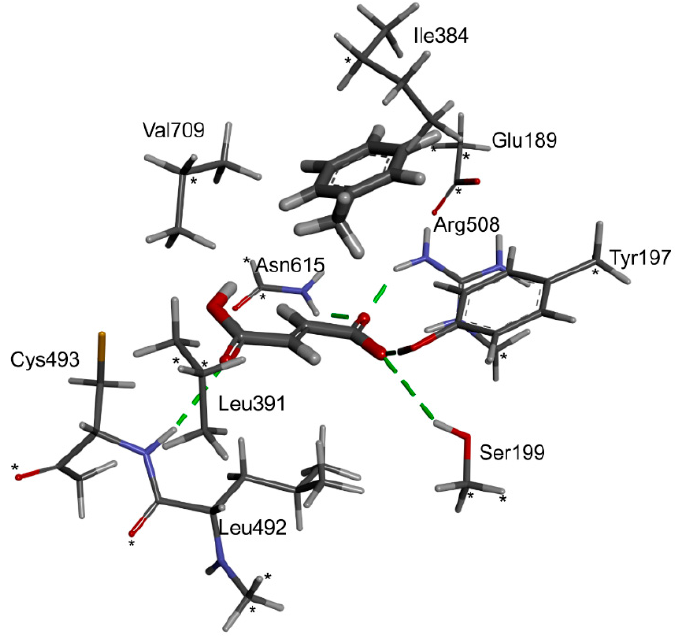
Figure 11. The structure of the cluster model used in QM modeling. The substrates toluene and fumarate are highlighted by thicker lines. The green lines depict hydrogen bonds stabilizing bound fumarate in the active site. Stars indicate atoms which positions were constrained in the geometry optimization.